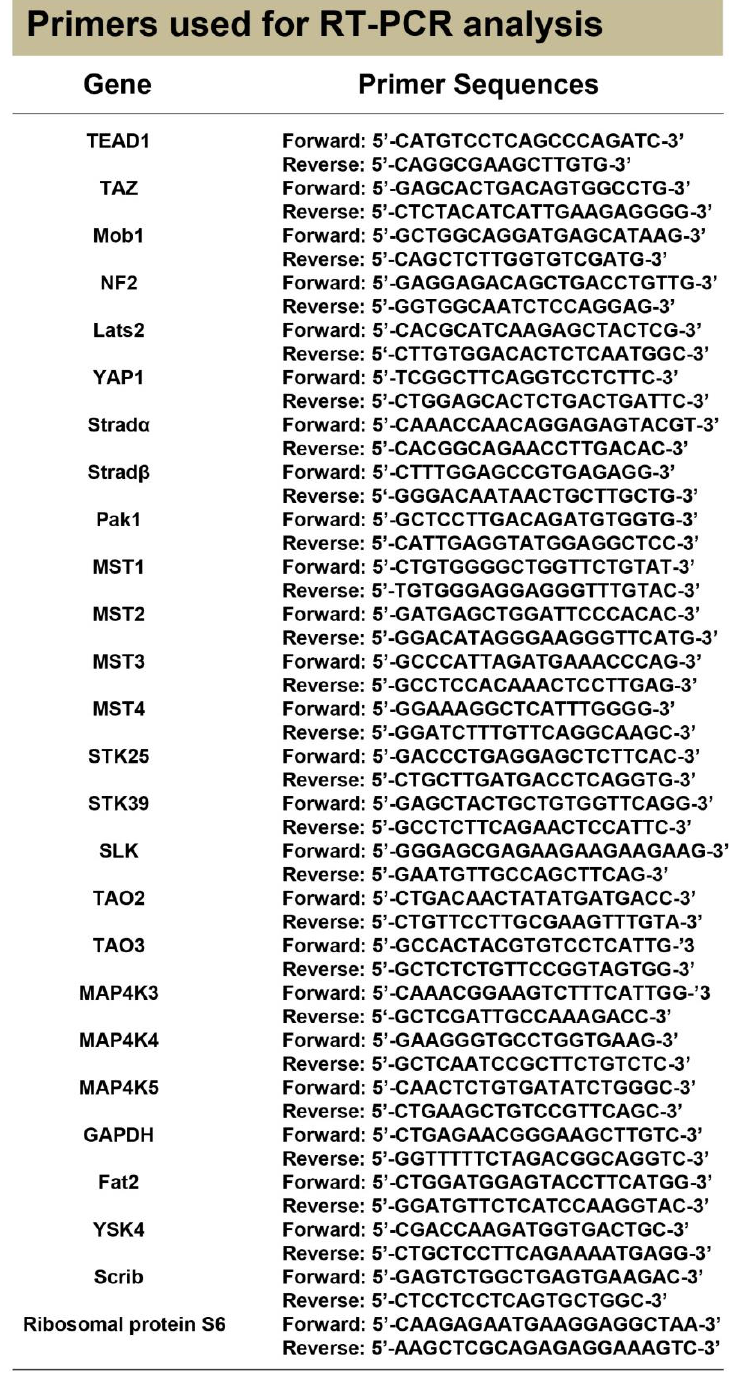
Figure S6. Nucleotide sequences of PCR primers used in the